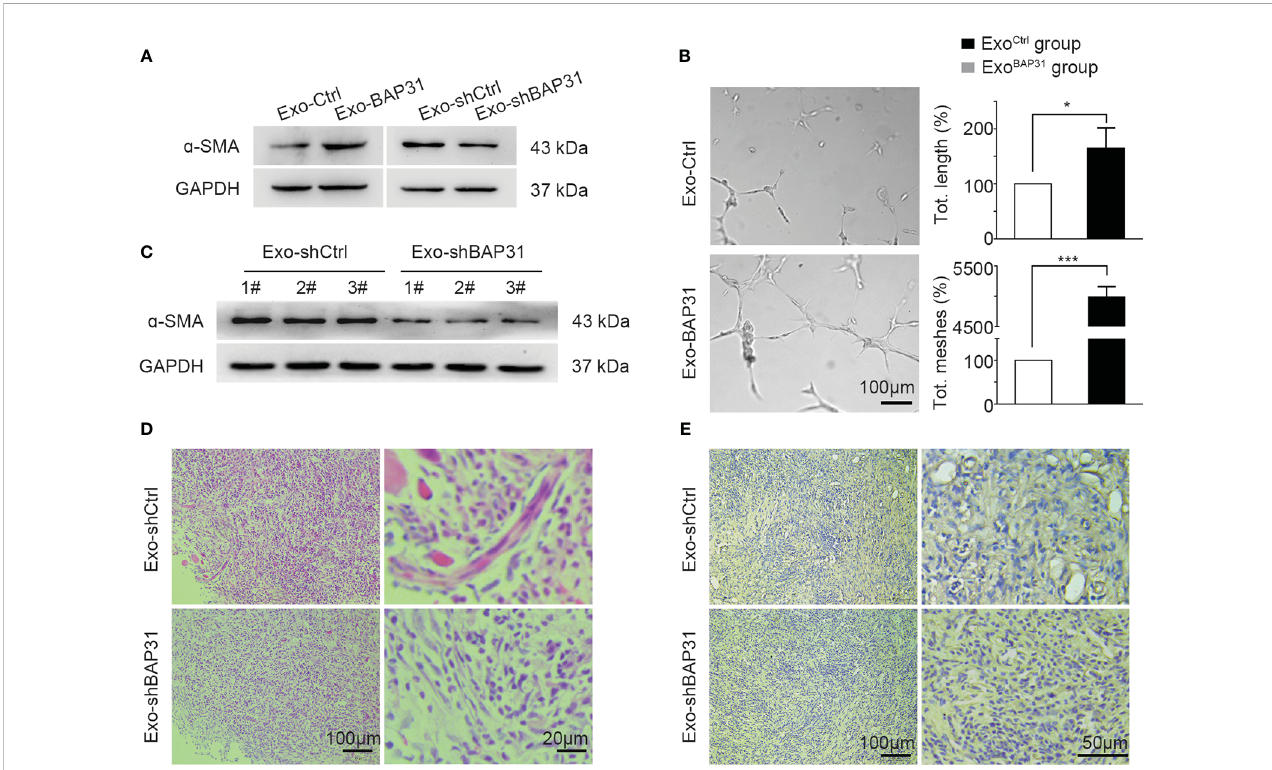
FIGURE 2 Exosomes from BAP31-overexpressing CRCs promoted fi broblast activation. Fibroblasts were treated by exosomes from BAP31-overexpressing/BAP31- knockdown CRCs. (A) Western blot analysis shows the a -SMA expression in fi broblasts. (B) The endothelial cells were treated by the conditioned medium from the fi broblasts. Tube formation analysis shows the angiogenic ability of the endothelial cells. Scale bar, 100 m m. Mean ± SEM are provided (n = 3). * p < 0.05 and *** p < 0.001. Mouse fi broblasts (NIH/3T3) were treated by exosomes from BAP31-knockdown CRCs. Mouse CRCs (MC38) were mixed with the fi broblasts and then injected subcutaneously into BALB/C mice. (C) Western blot analysis shows the a -SMA expression in tumor tissues. (D) H&E staining images show fi broblast differentiation in tumor tissues. (E) Immunohistochemistry (IHC) staining (CD31) images show the vascular structures in tumor